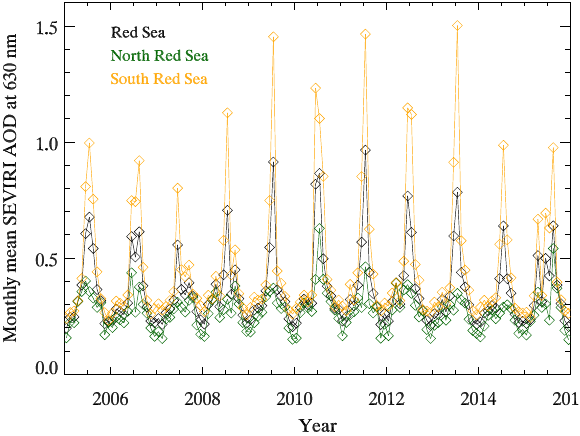
Figure 2. Time series of monthly average AOD at 630nm from SE- VIRI in the Red Sea. Colours represent individual years, and south and north are divided by the line of 20 ◦